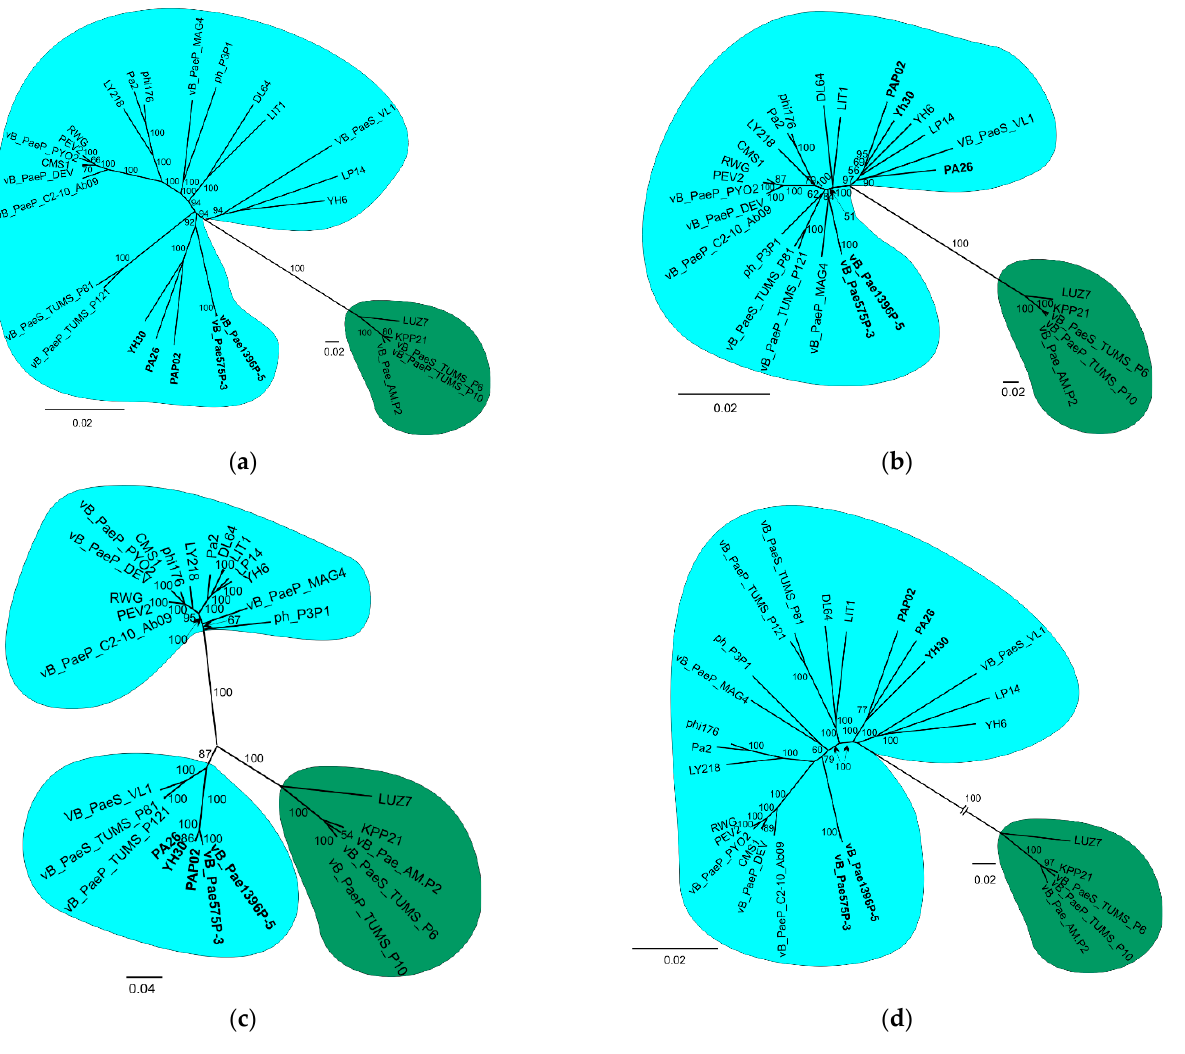
Figure 2. Four strategies of Litunavirus phylogenetic analysis: ( a ) whole-genome tree; ( b ) core-genome tree; ( c ) variable region tree; ( d ) whole-genome minus variable region tree. Litunavirus and Luzseptimavirus phages are circled in blue and green, respectively. Bootstrap support values are presented on branches, and phylogenetic distance scale is shown as a bar for the whole graph ( c ) or distinct clades in its proximity ( a , b , d ). The most crucial viral taxa are presented in